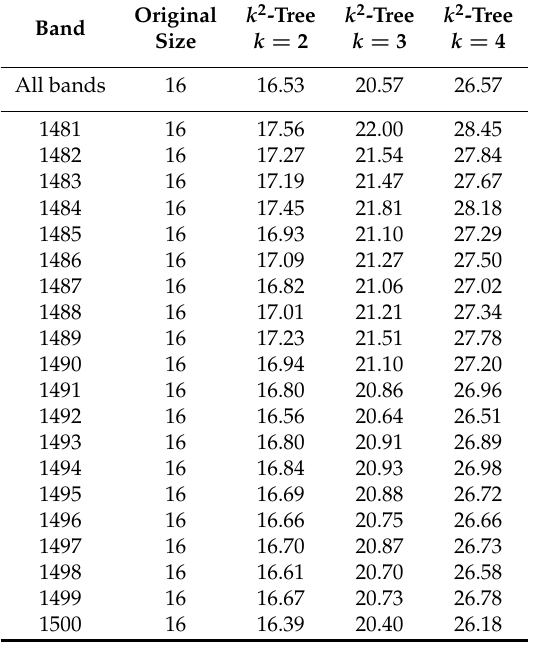
Table 13. A comparison of the storage size (in bpppb) using different integer encoders on Lmax and Lmin from the k 2 -raster built from our datasets. The combined entropies for Lmax and Lmin are listed as a reference. The l value that was used in Rice codes is enclosed in brackets. The best and optimal k values for DACs are also enclosed in brackets. Except for the entropy, the best rates for each scene’s data are highlighted in